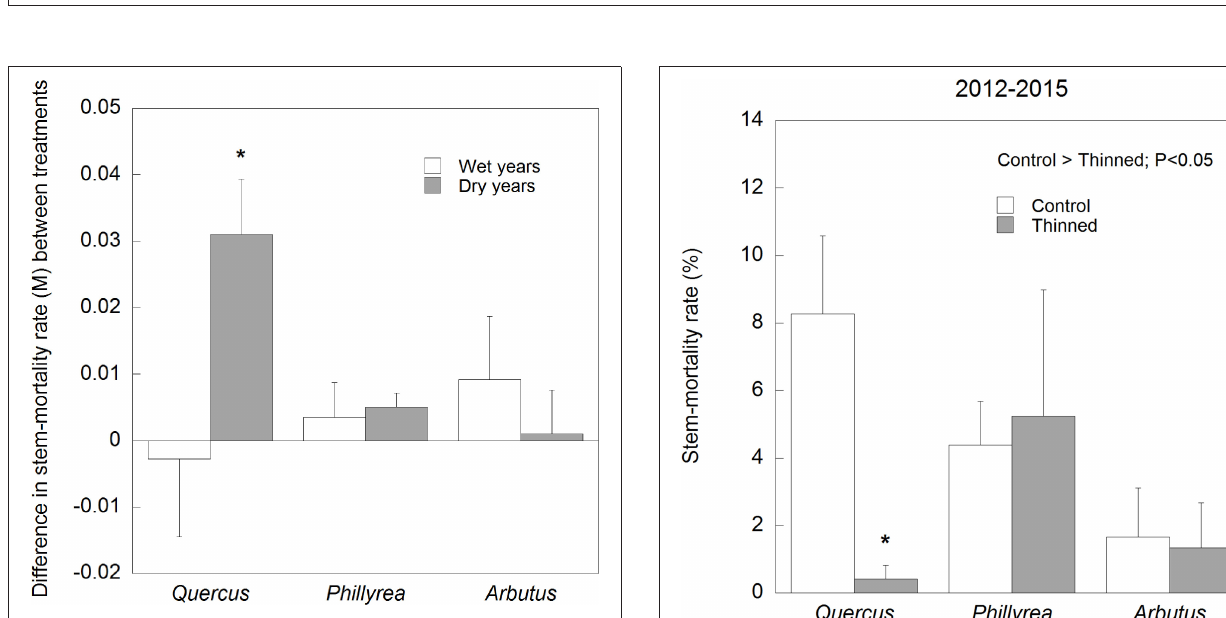
FIGURE 7 | Annual stem-mortality rates in the control and TDE plots for Q. ilex (A) , P. latifolia (B) , and A. unedo (C) . Error bars correspond to the standard error of the mean ( n = 4). * P < 0.05.